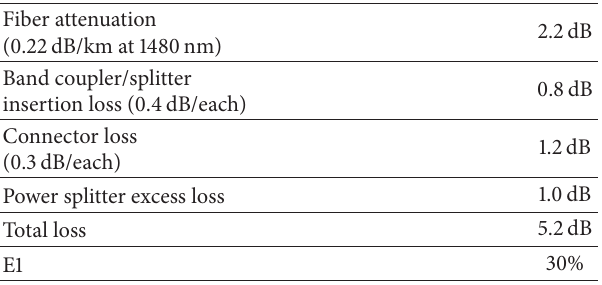
Table 2: Optical link loss.